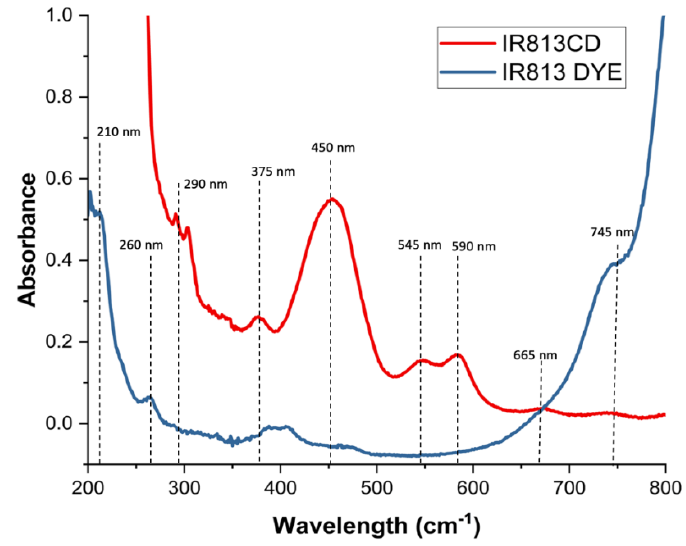
Figure 1. UV-vis analysis of 813-CDs and IR-813 dye.